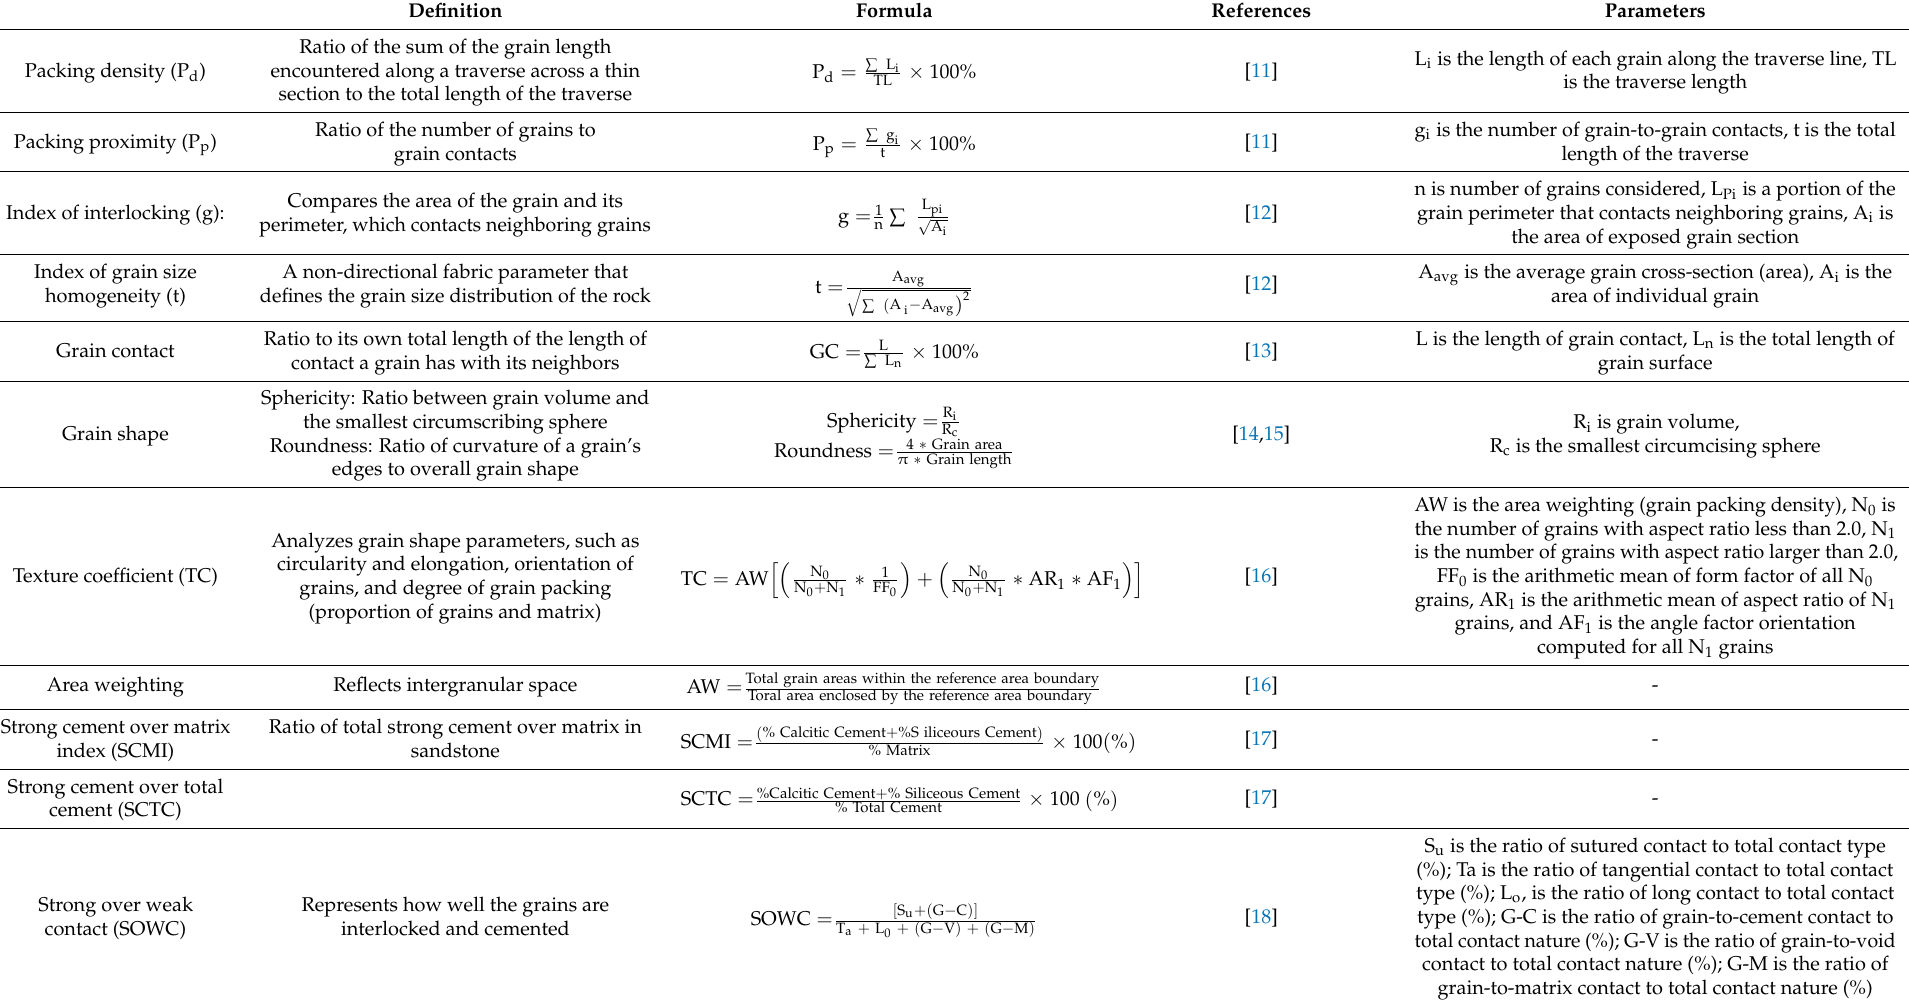
Table 2. Rock textural parameters (The parameters are adapted from the mentioned